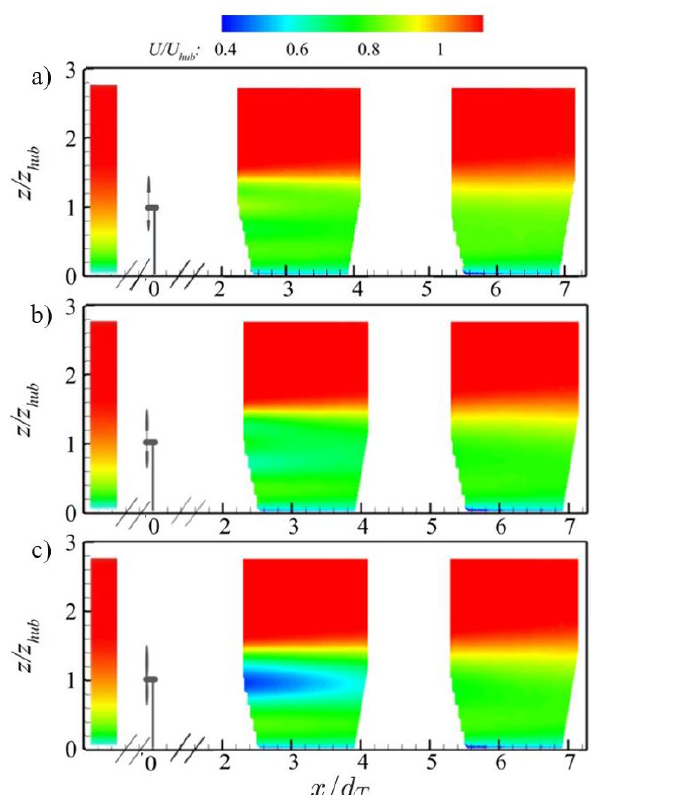
Figure 4. Mean velocity distribution, U / U hub , in the central plane for the turbines with blade length ratios of L / R = ( a ) 0.6, ( b ) 0.7, and ( c ) 1.